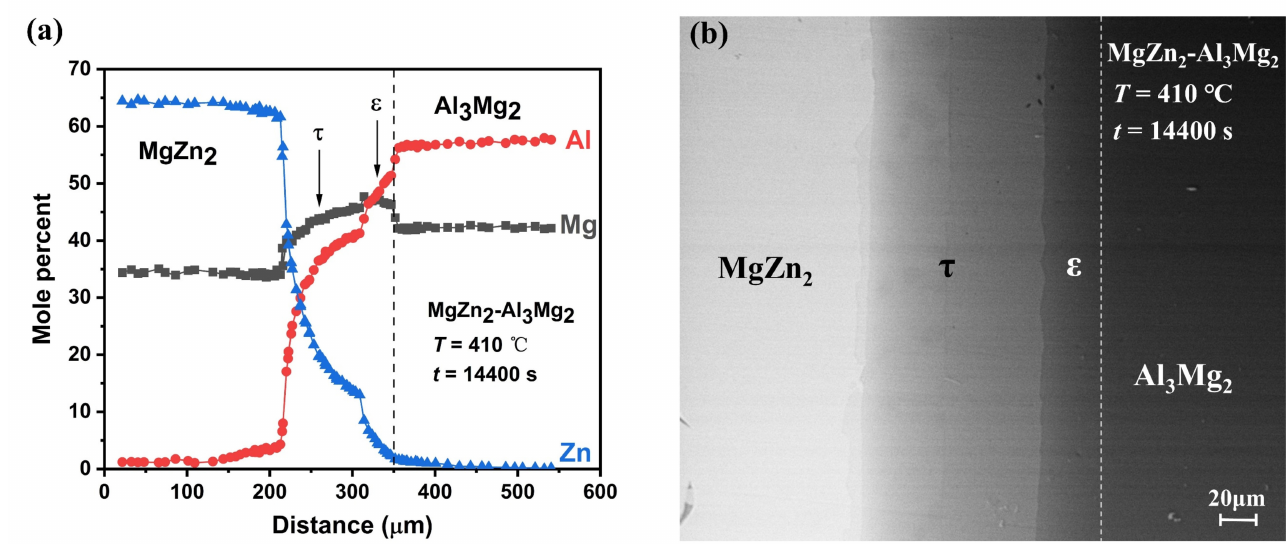
Figure 6. ( a ) EPMA data of MgZn 2 -Al 3 Mg 2 diffusion couple annealed at 410 ◦ C for 4 h. ( b ) SEM image of MgZn 2 -Al 3 Mg 2 diffusion couple annealed at 410 ◦ C for 4